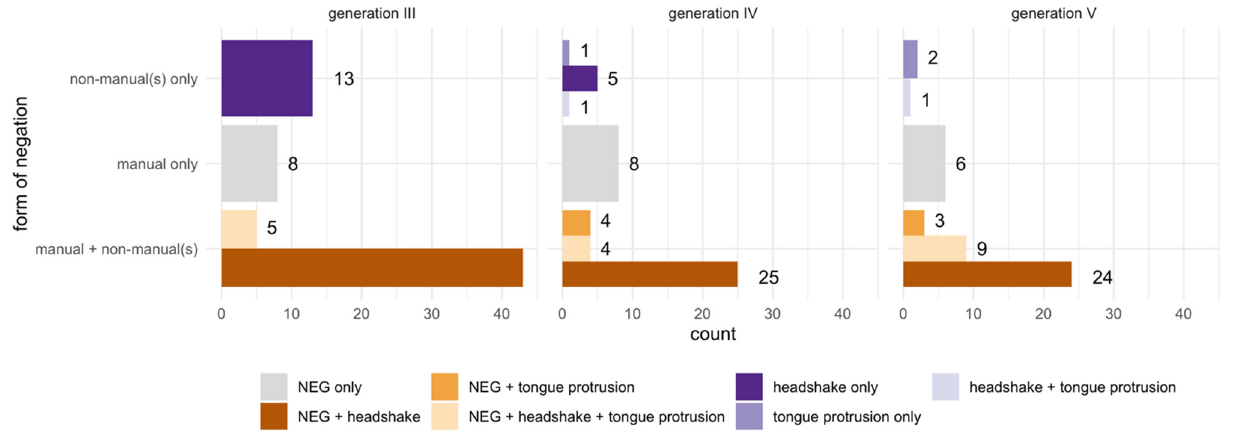
Figure 2. Combinatorial patterns of relevant manual and non-manual markers shown per genera- tion.